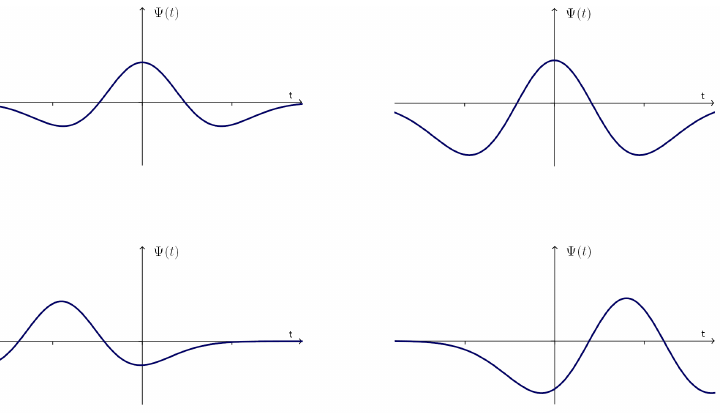
Figure 1. Different scales and shifts of the Ricker wavelet, also known as the “Mexican hat”